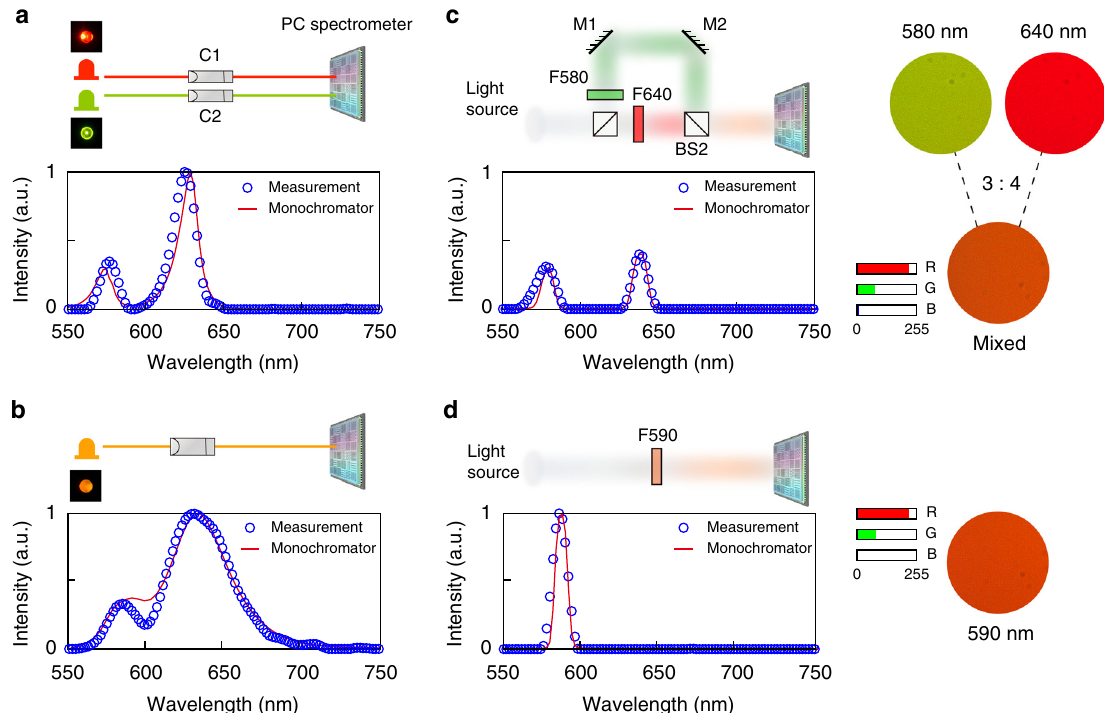
Fig. 3 Recovery of broadband spectra. Measurements of a the emission spectrum of a combination of two LEDs (green and red), and b the emission spectrum of a multimode LED (orange/red). C, collimator. c , d Two different spectra appear as the same RGB color. M, mirror; F, fi lter; BS, beam splitter. c A light beam from a lamp (ASBN-W) is split into two beams, and recombined in a power ratio of 3:4 after passing through two different bandpass fi lters at 580±5nm (Thorlabs, FB580) and 640±5nm (Thorlabs, FB640), respectively. The spectrum of the recombined beam is then analyzed by the PC spectrometer. d Measurements for a white light beam (ASBN-W) passing through a bandpass fi lter at 590±5nm (Thorlabs, FB590). For all four cases, the measurement results using the PC spectrometer (circled lines) match well with reference spectra obtained by a commercial monochromator (red solid